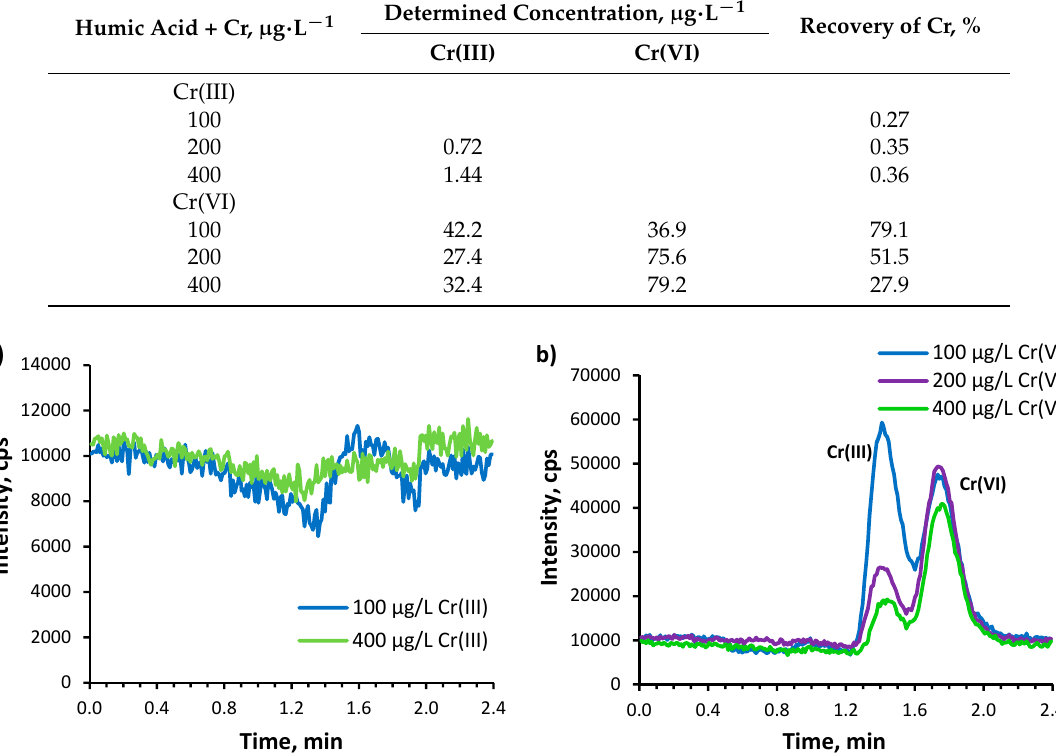
Figure 4. Chromatogram of ( a ) Cr(III) and ( b ) Cr(VI) standards at a concentration of 100–400 µg L − 1 containing humic acids (0.7 g L − 1 ) obtained after 24 h incubation at room temperature, recorded at m / z 52.